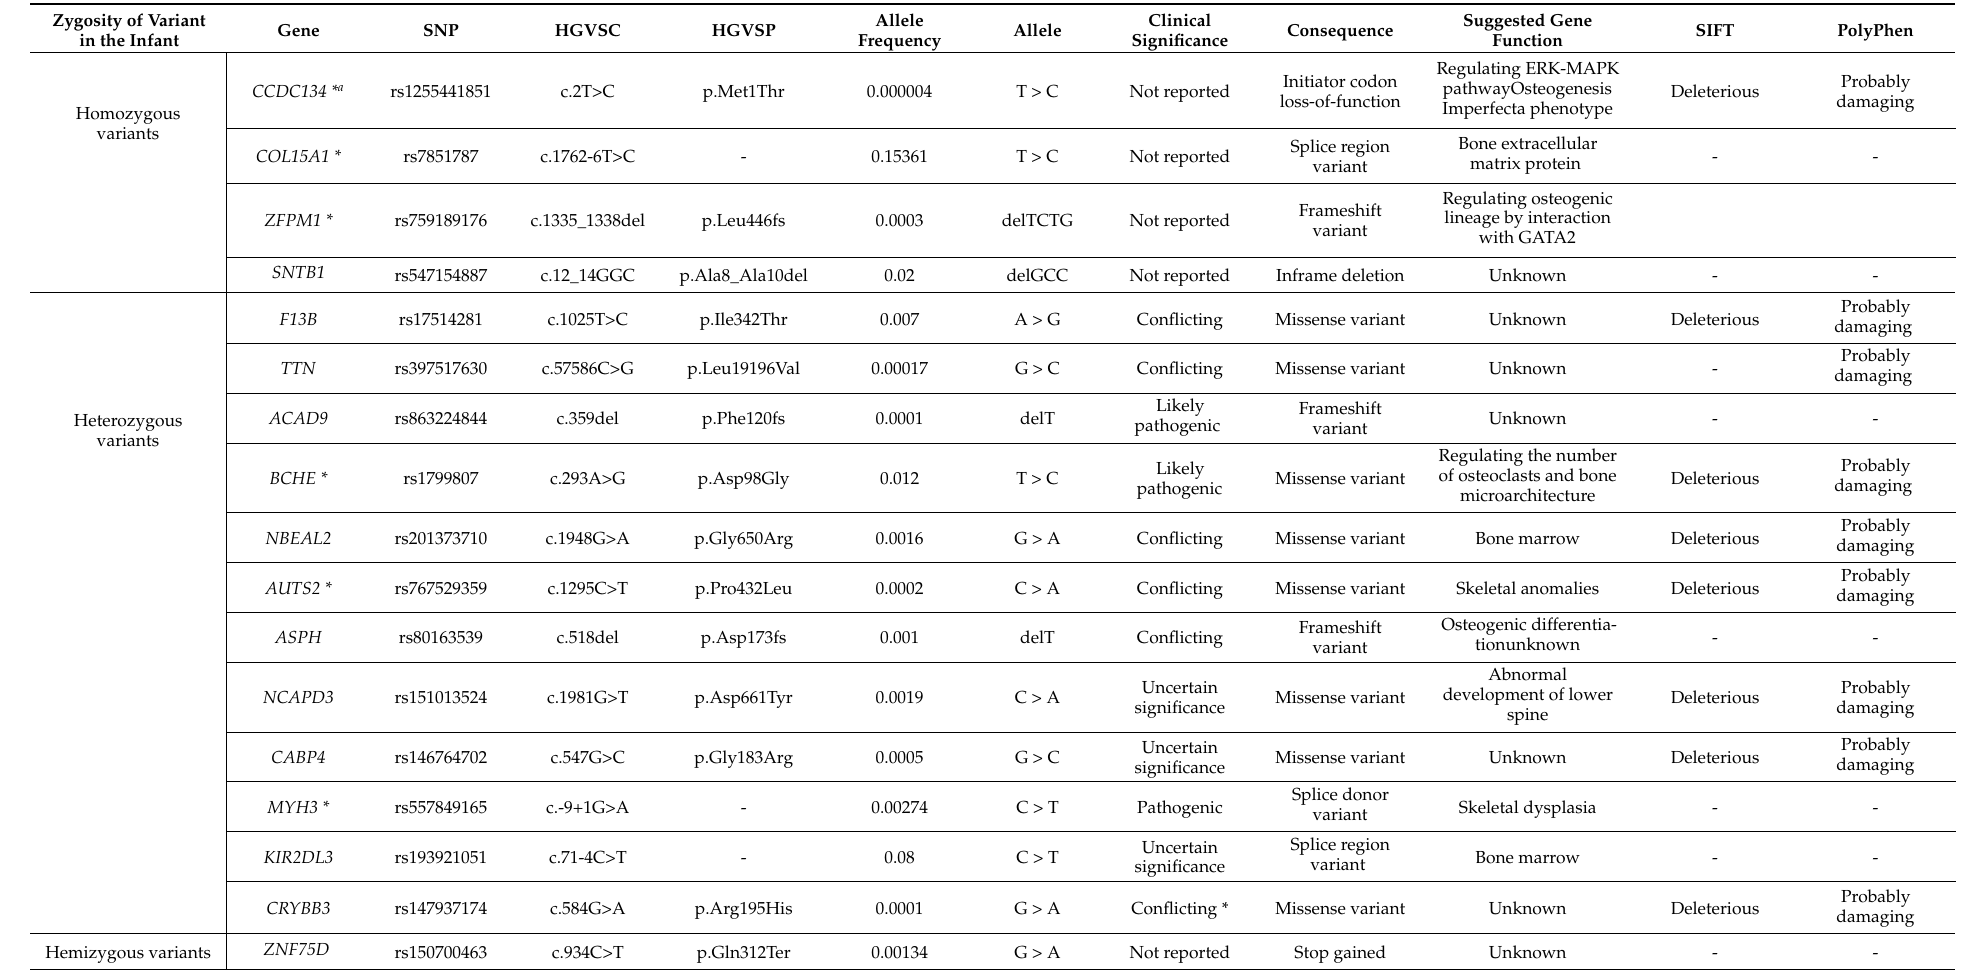
Table 2. The filtered variants in the infant with multiple intrauterine